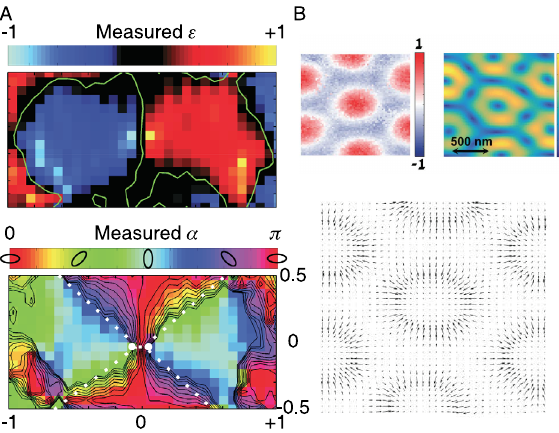
Figure 7: (A) Observation of polarization singularities such as C-points and disclinations in the near field of a photonic crystal waveguide using a NSOM. The measured azimuthal angle map and ellipticity mapbothshow theexistenceof polarization singularities. (B)Anexampleofnear-fieldpolarizationsingularitymanipulation.A lattice of V-points, called an ‘ optical skyrmion lattice ’ , was gener- ated using a hexagonal-shaped plasmonic grating. (A) is adapted from [120], (B) from